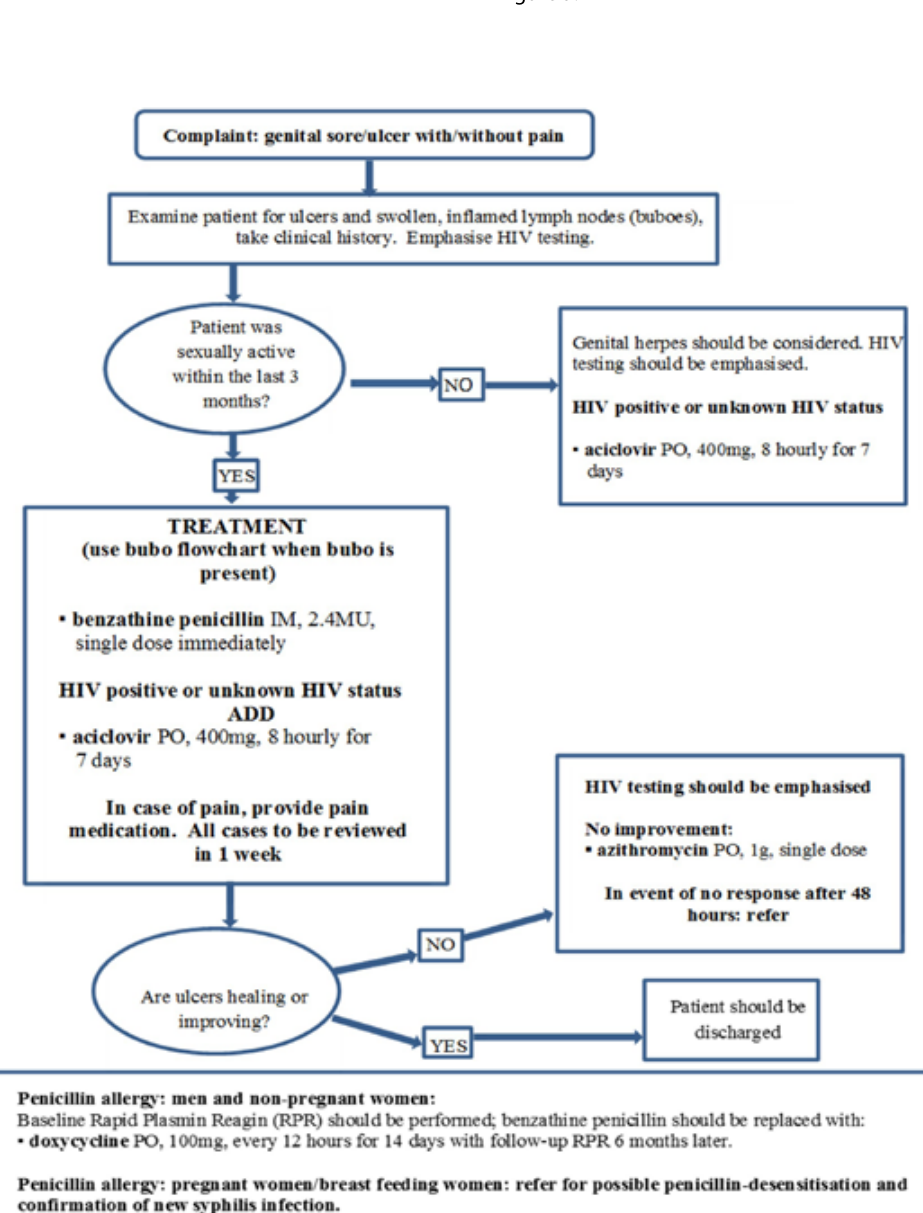
Figure 5: Flowchart of syndromic treatment of Genital Ulcer Syndrome. (adapted from the revised GUS flowchart of the Primary Health Care Standard Treatment Guidelines and Essential Drugs List, 2015)